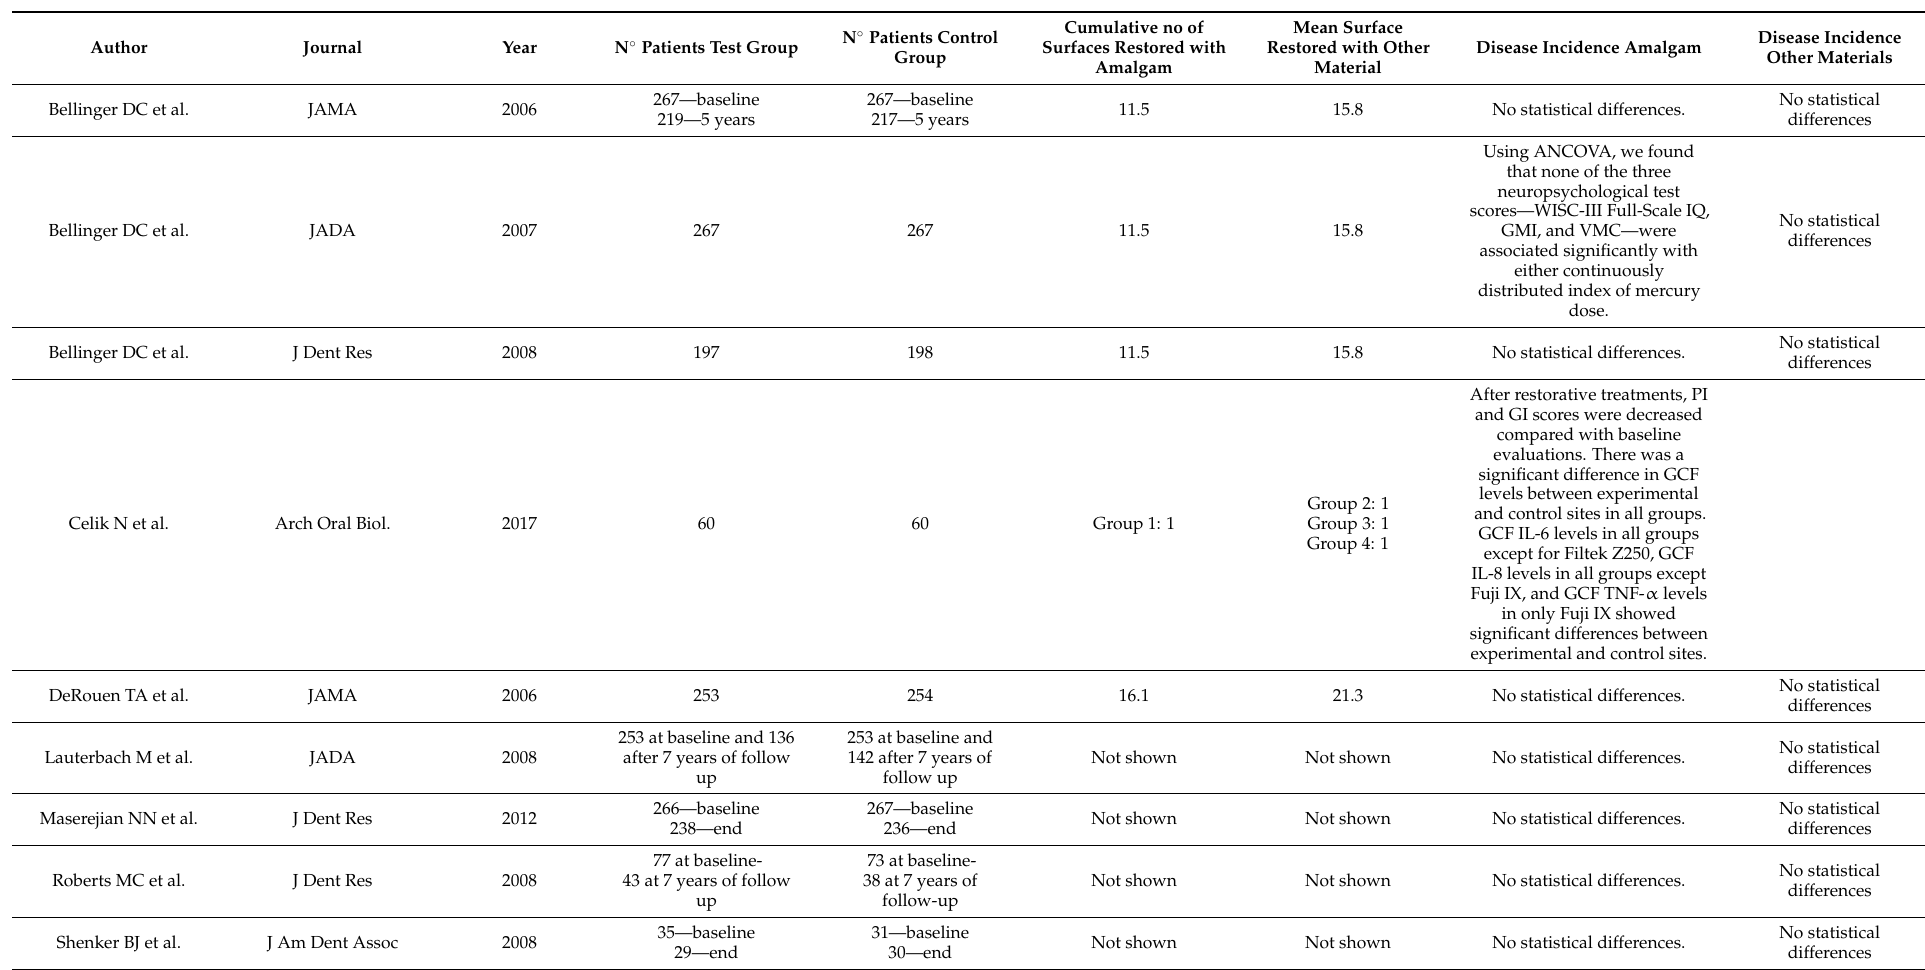
Table 2. Results of the individual included studies in the present systematic